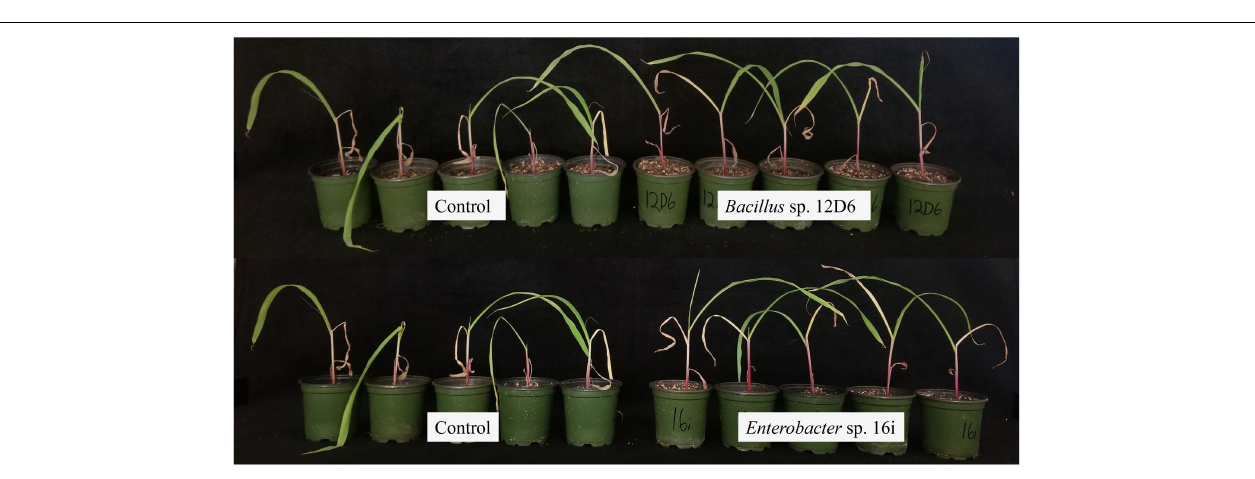
FIGURE 2 | Maize seedlings treated with plant growth-promoting rhizobacteria (PGPR). Bacillus sp. 12D6 (top right) and Enterobacter sp. 16i (bottom right) demonstrated the delayed onset of drought symptoms in maize seedlings versus control (top left and bottom left) after exposure to 7 days of continuous water